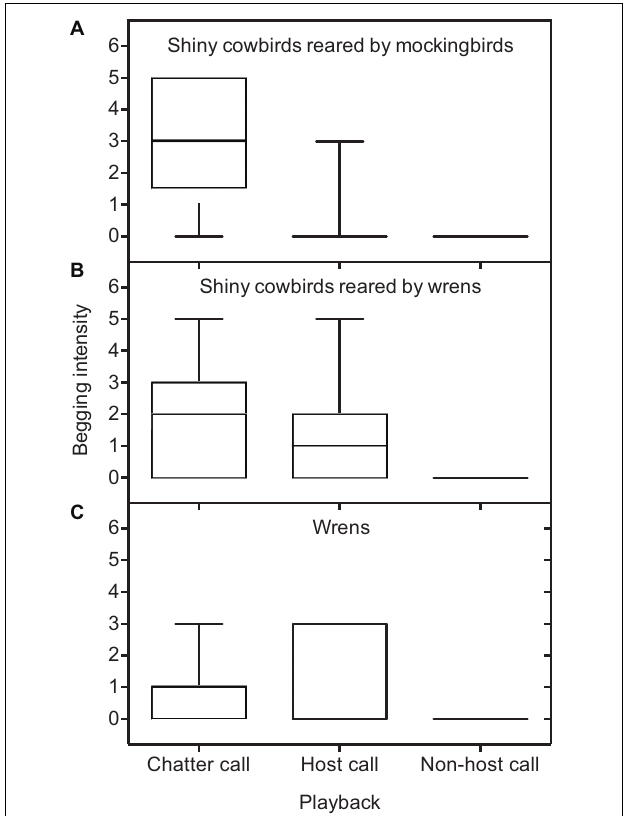
FIGURE 2 | Intensity of the begging response of the three chick categories for different playback treatments (chatter, host, and nonhost playbacks): (A) shiny cowbirds reared by mockingbirds, (B) shiny cowbirds reared by wrens, and (C) wrens. Boxplots show medians, interquartiles, and ranges.